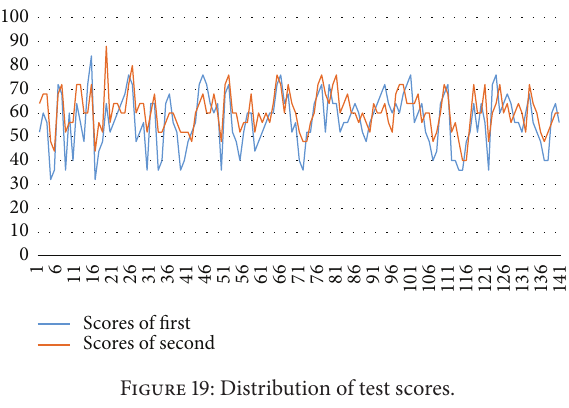
Figure 19: Distribution of test scores.